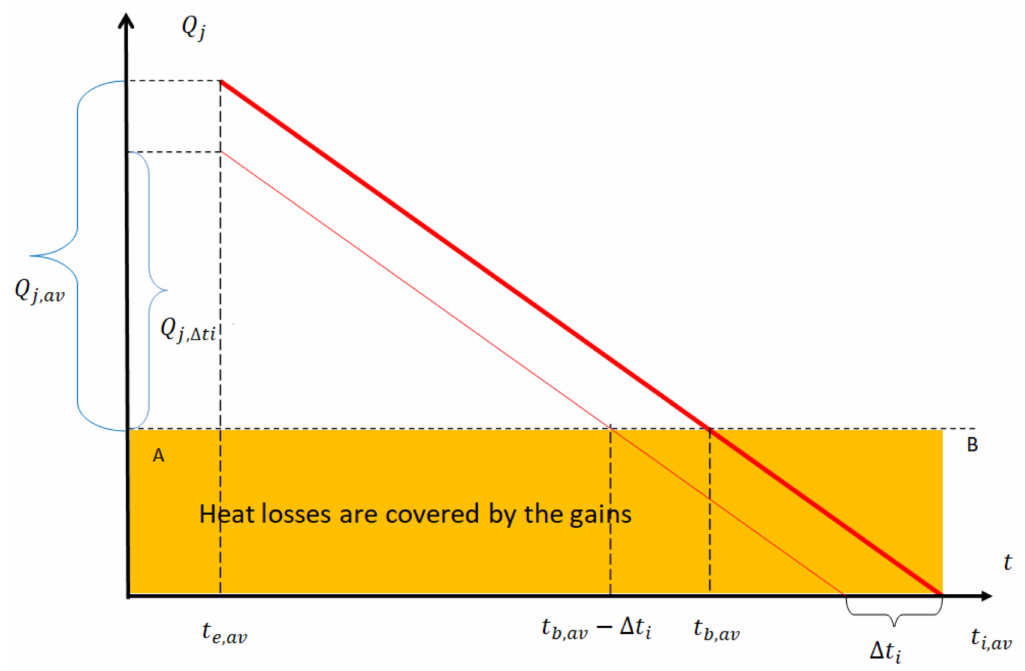
Figure 1. Dependence of individual heat consumption ( Q j ) on outdoor temperature ( t e